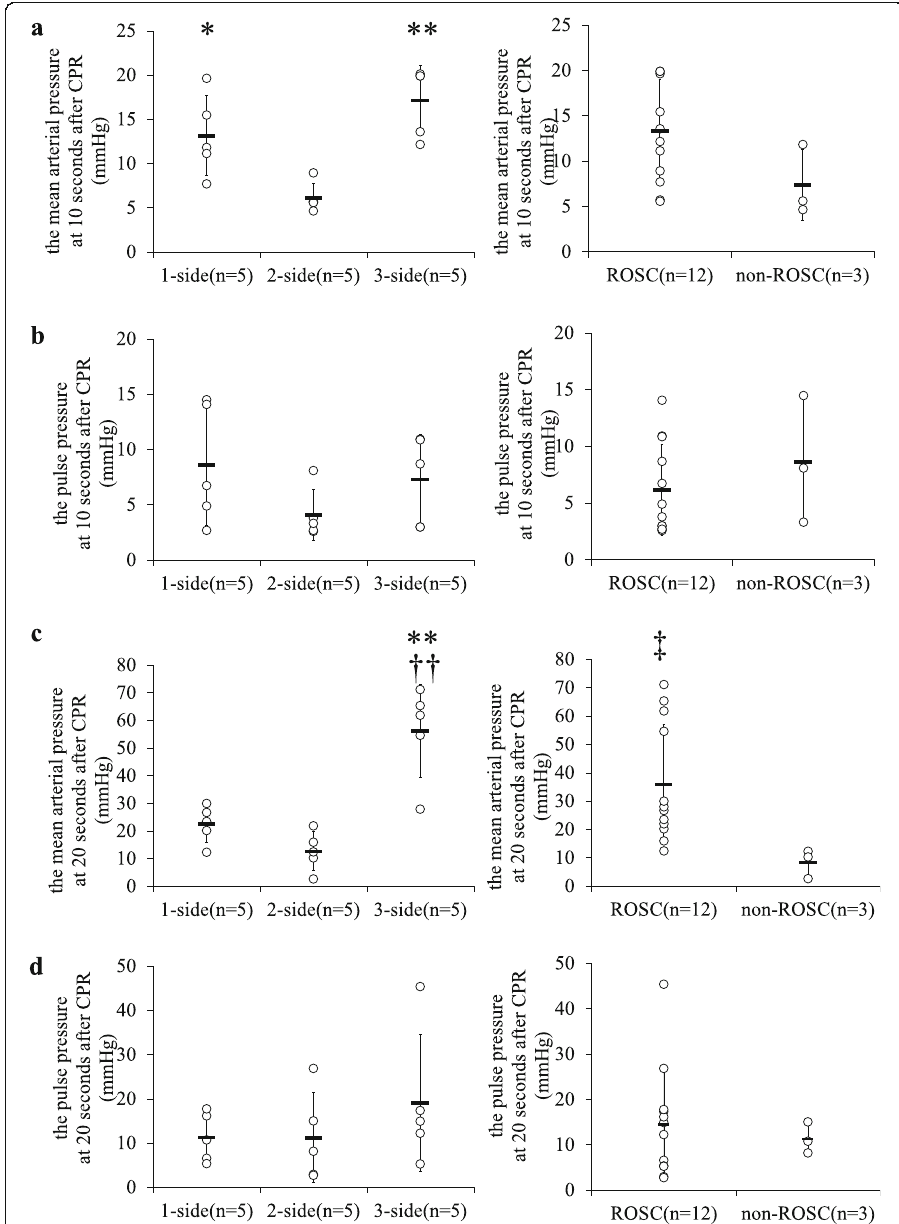
Fig. 2 The evaluation of the mean arterial pressures (MAP) and the pulse pressure (PP) at 10 s after CPR and at 20 s after adrenaline injection. a This figure shows MAP at 10 s after CPR starting. The results are shown as mean ± SD. * P < 0.05 compared with the 2-side group. ** P < 0.01 compared with the 2-side group. b PP for 10 s after CPR starting. The results are shown as mean ± SD. c MAP for 20 s after adrenaline injection. The results are shown as mean ± SD. †† P < 0.01 compared with the 1-side group. ** P < 0.01 compared with the 2-side group. ‡ P < 0.05 compared with the non-return of spontaneous circulation (ROSC) group. d PP for 20 s after adrenaline injection. The results are shown as mean ±